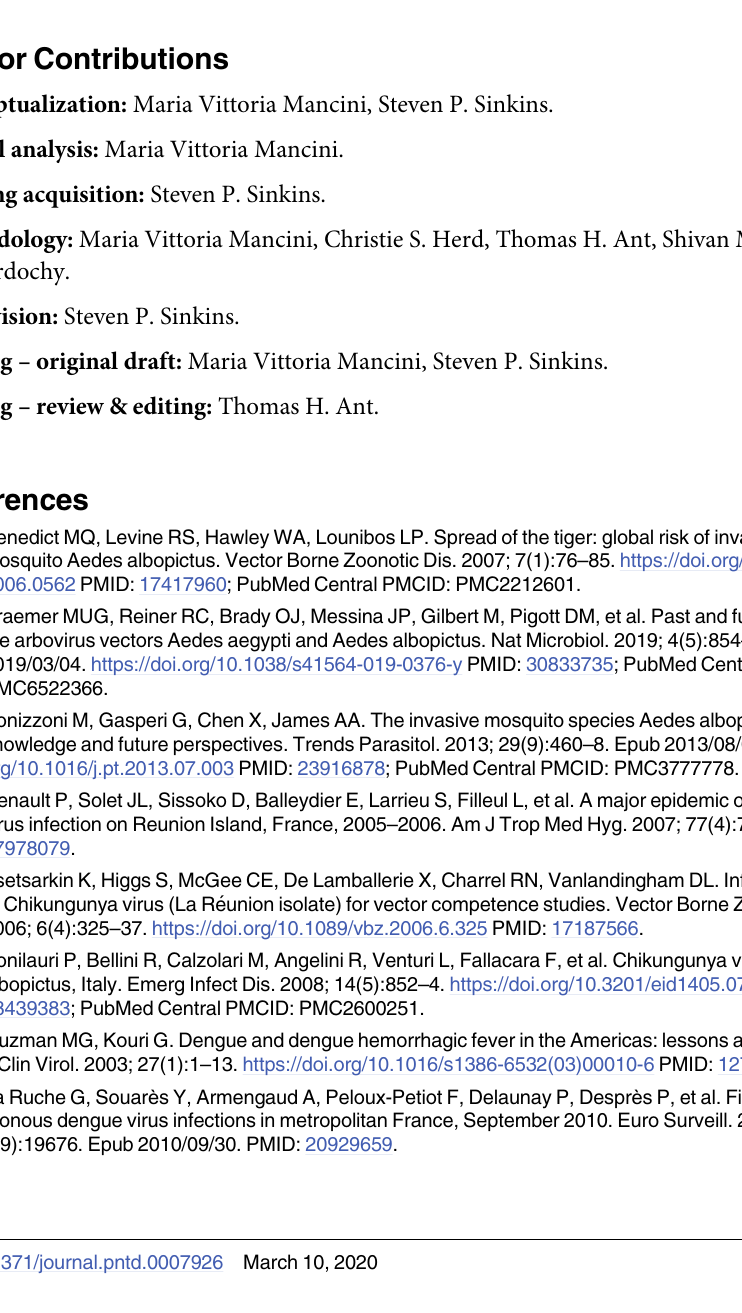
S1 Fig. Fluorescent in situ hybridization. Visualization of distributions of general Wolbachia (green) in ovaries of 5-day old females from the wild-type (A), JF. w Au (B), Ae . aegypti - w Au lines (C) and a no-probe control on wild-type (D). Blue stain is DAPI. (TIF) S1 Table. List of sequences of oligonucleotides and probes.